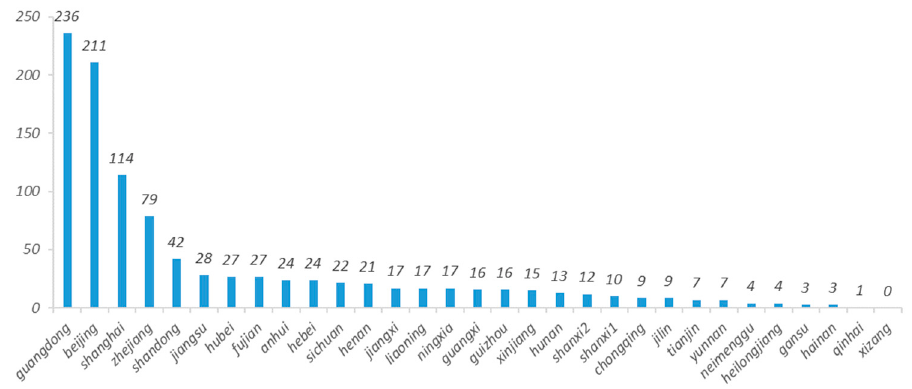
Figure 2. Number of normal operating online lending platforms in all provinces of China at the end of 2018.